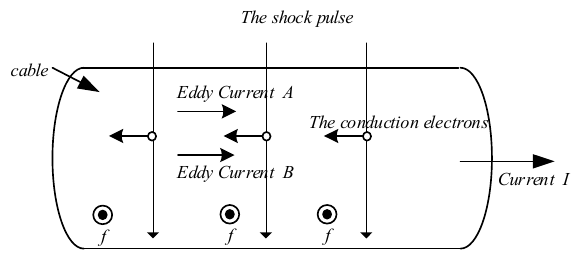
Figure 3. The eddy current caused by impulse pulse.